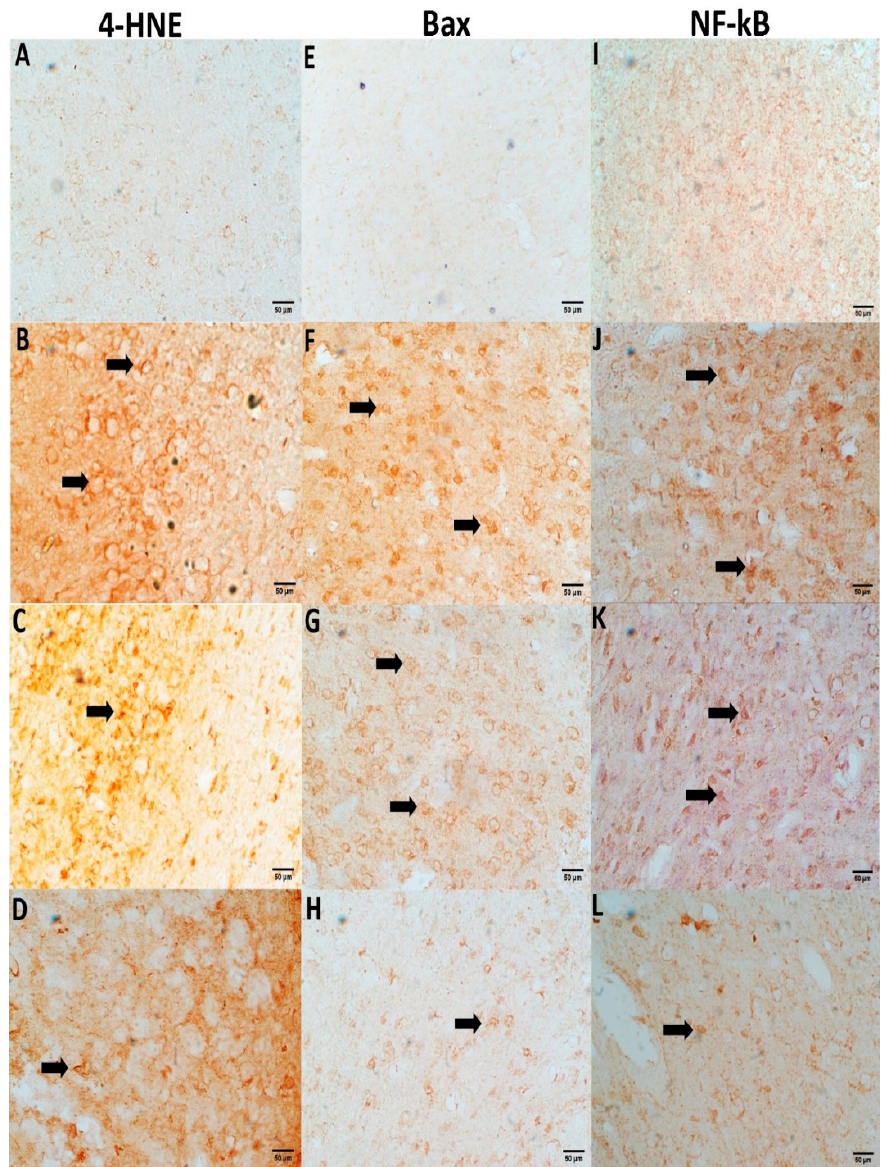
Figure 5. NC treatment suppresses immunochemical staining for 4-HNE, Bax, and NF-kB. Slides from the control group ( A , E , I ) show negative stains of neurons. A positive neuronal staining with high density was observed in the CPM group for 4-HNE ( B ), Bax ( F ) and NF-kB ( J ) (arrows). However, Positivity in neurons staining for the NC-treated group (2.5 and 5 mg) were successfully reversed as compared to the CMP group (4-HNE ( C , D ), Bax ( G , H ), and NF-kB ( K , L ).